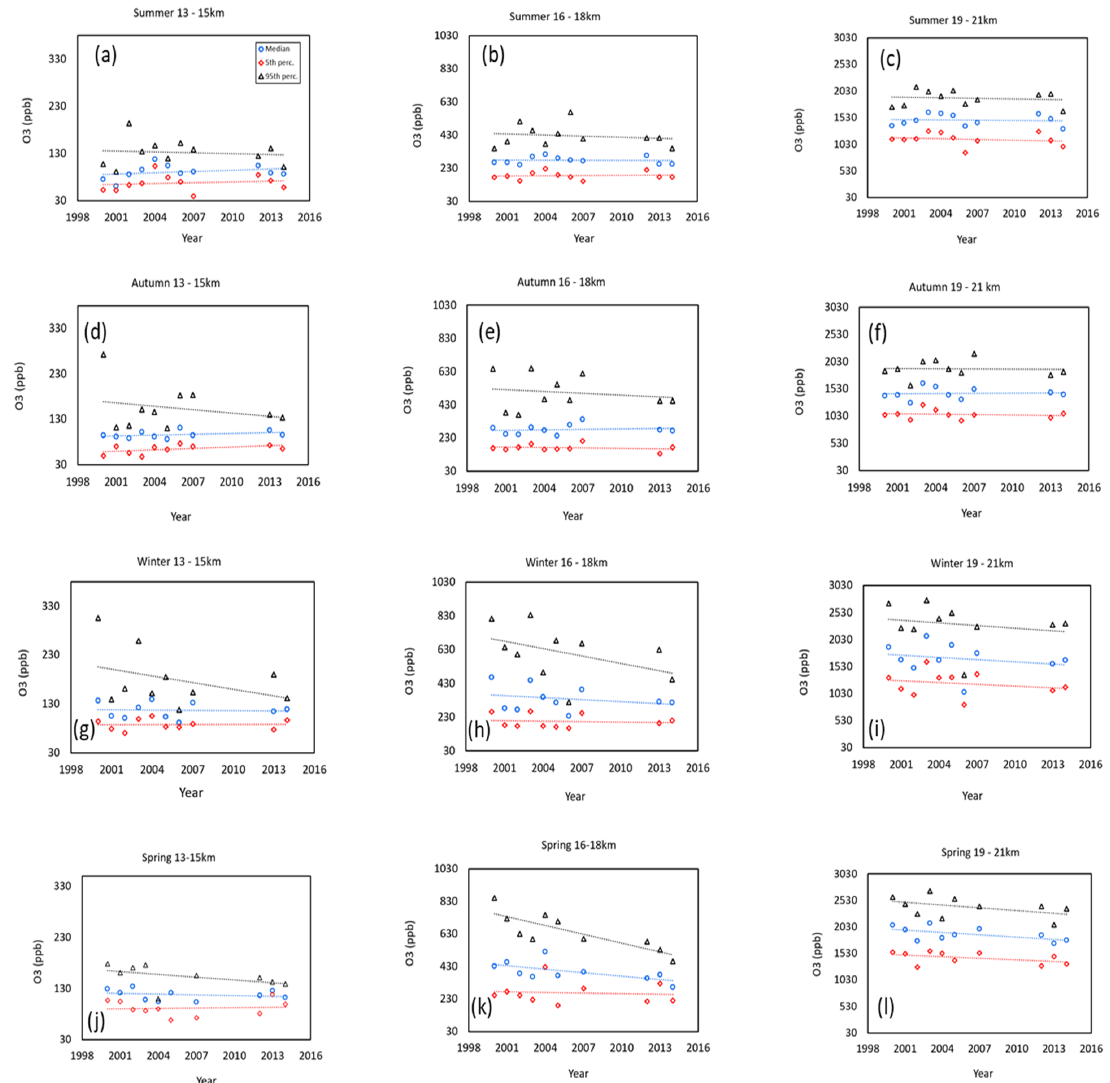
Figure 13. Ozone time series (2000–2015) of the 5th (red), median (blue) and 95th (black) percentile ozone mole fractions at different altitude, ( a ) summer 13–15 km, ( b ) summer 16–18 km and ( c ) summer 19–21 km, ( d ) autumn 13–15 km, ( e ) autumn 16–18 km, ( f ) autumn 19–21 km, ( g ) winter 13–15 km, ( h ) winter 16–18 km, ( i ) winter 19–21 km, ( j ) spring 13–15 km, ( k ) spring 16–18 km and ( l ) spring 19–21 km. Dashed lines represent the linear fit for each time series. Table 4. Ozone statistical summary at different altitudes and seasons. Median Altitude 5th Percentile [ppb/year] 95th Percentile [ppb/year] [ppb/year] (a). Summer (± indicates the standard deviation)